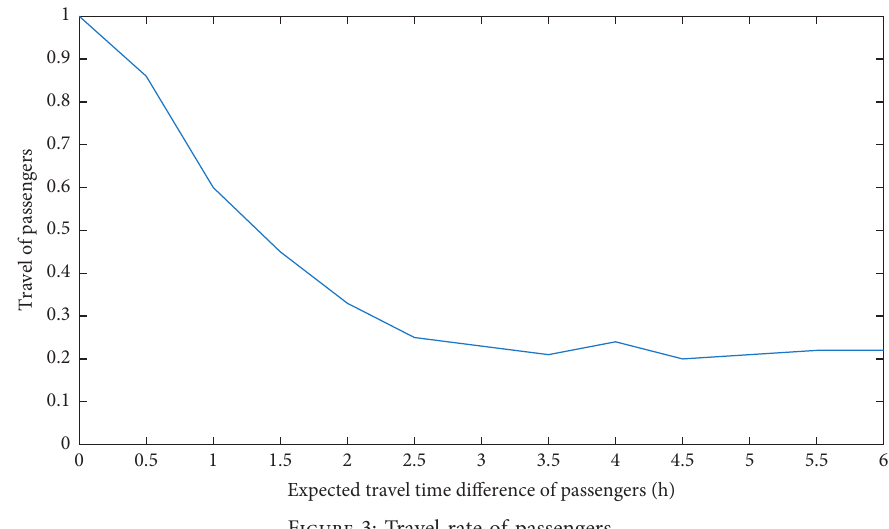
Figure 3: Travel rate of